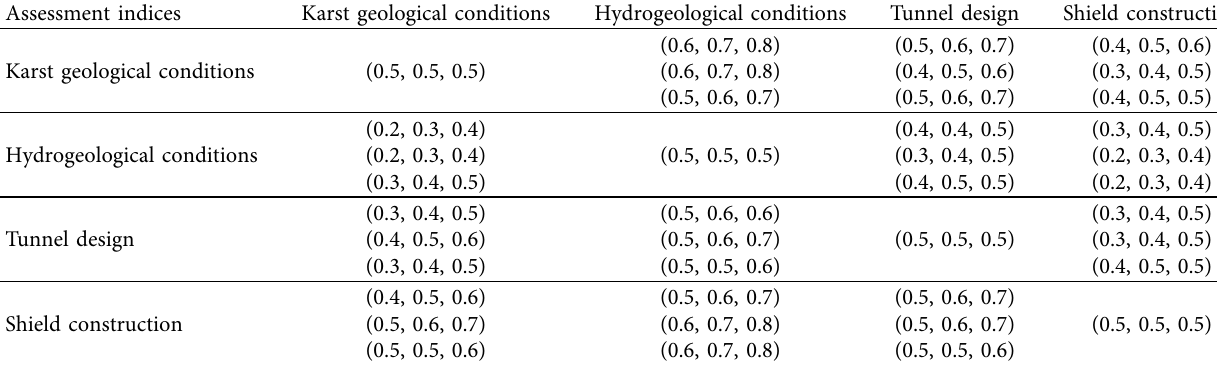
Table 4: Scoring results of the experts on the first-level indices.